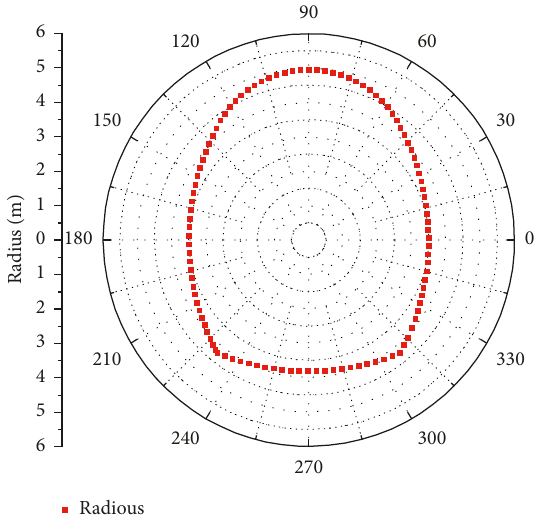
Figure 8: Polar coordinates of tunnel lining section